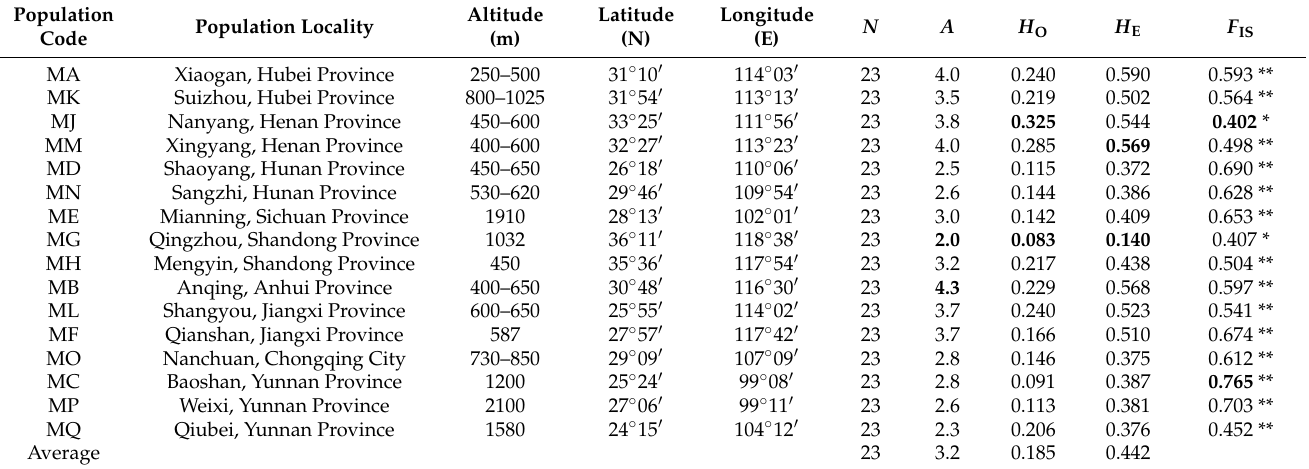
Table 1. Information about of collection sites, sample sizes ( n ), genetic diversity parameters of the 16 natural populations of Prunus persica .